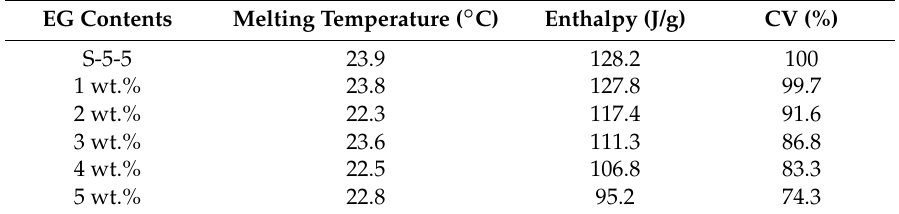
Figure 12. DSC curves of Na 2 SO 4 ·10H 2 O composites with varying contents of EG. Table 3. Thermal properties of Na 2 SO 4 ·10H 2 O composites with varying contents of EG.